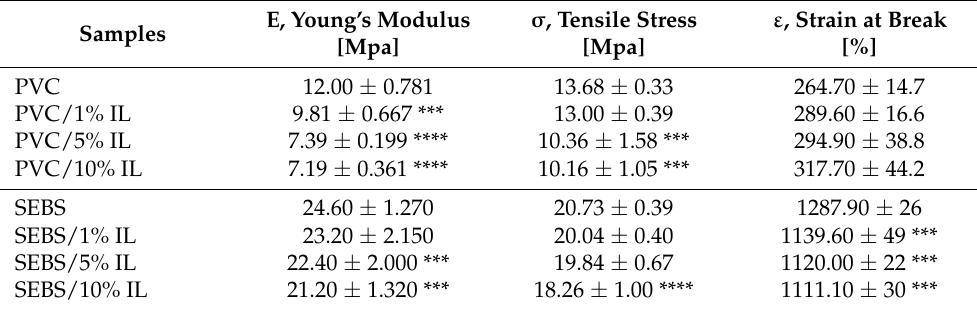
Table 1. Mechanical properties (Young’s Modulus E; Tensile Stress σ ; Strain at Break [%] ε ) of the PVC/IL and SEBS/IL blends are reported as mean values of PVC/IL (n = 5) and SEBS/IL (n = 6) replicates ± SD. A statistical comparison between the different groups and each of them with their related controls (neat polymers) was performed by One-Way ANOVA with Tukey’s multiple comparisons test. *** p < 0.001; **** p < 0.0001.